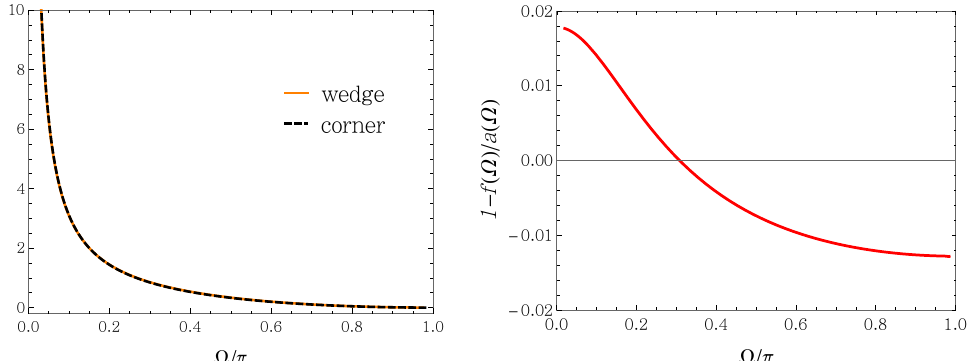
Figure 4 . (Left) We plot the wedge (orange) and corner (black dashed) functions f ((cid:10)) and a ((cid:10)) normalized so as to make them fall approximately on top of each other, as observed in [57]. (Right) We plot 1 (cid:0) f ((cid:10)) =a ((cid:10)). As we can see, both functions are in fact slightly di(cid:11)erent from each